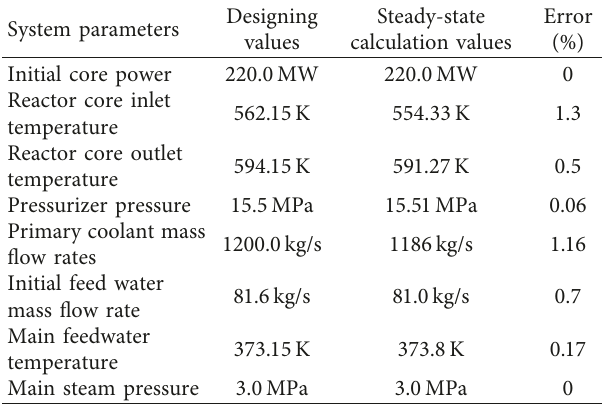
Table 1: Key parameters under the steady state for comparison. System parameters